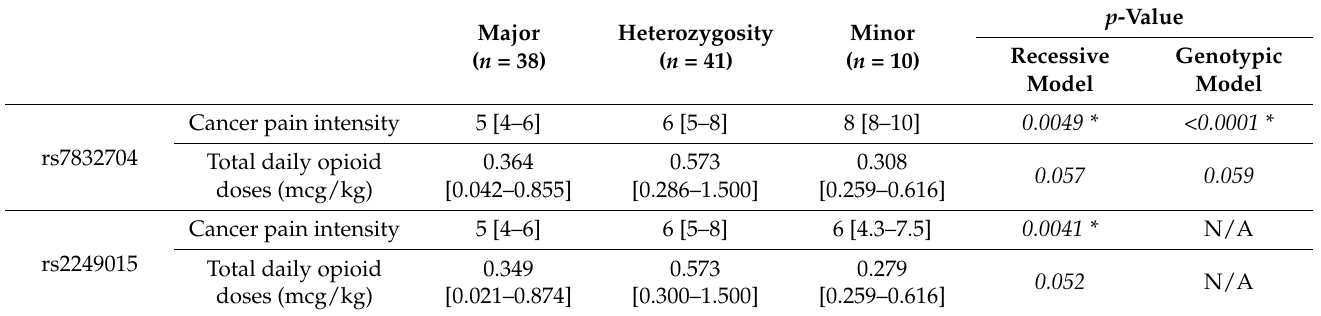
Table 1. Associations of ENPP2 single-nucleotide polymorphisms with cancer pain intensity and total daily opioid doses in confirmatory